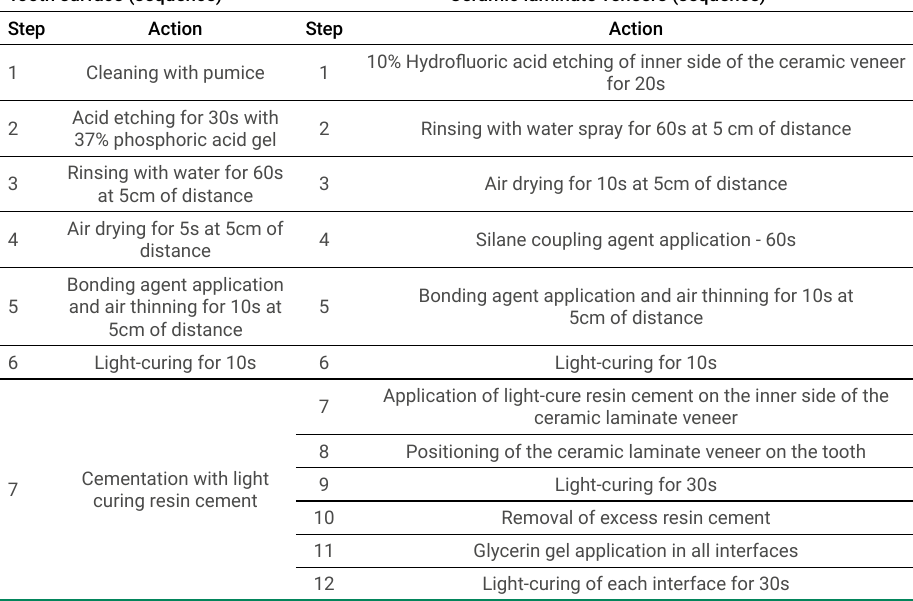
Figure 2. Sequence of adhesive procedures on tooth surfaces and ceramic veneers